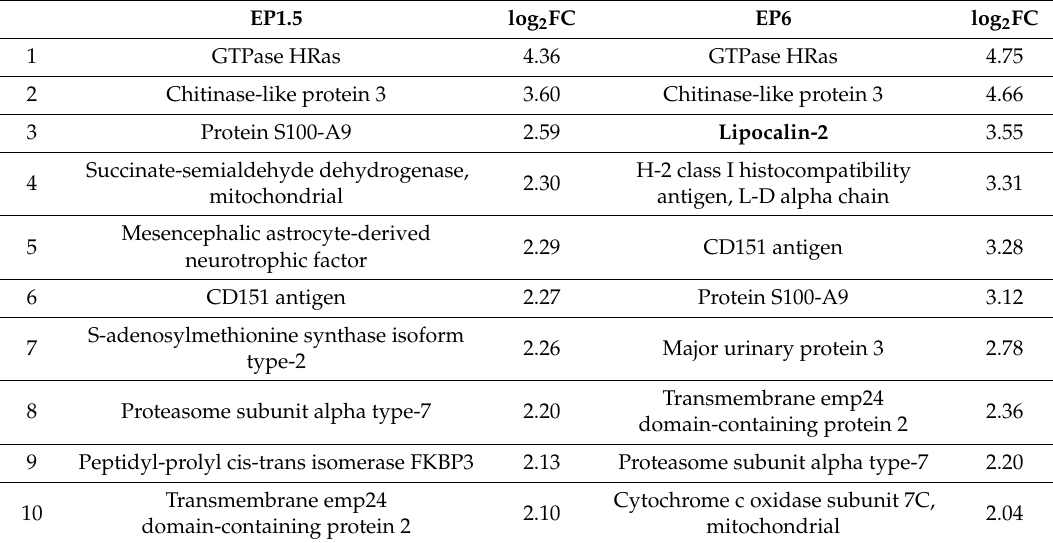
Table 1. Proteins significantly upregulated at least 4-fold (log 2 FC = 2) relative to the saline-injected control kidneys in EP in mice. Acute phase proteins (APPs) are highlighted in bold, proteins present at both time points are highlighted in grey. log 2 FC: log2 transformed values of fold change. EP1.5 log 2